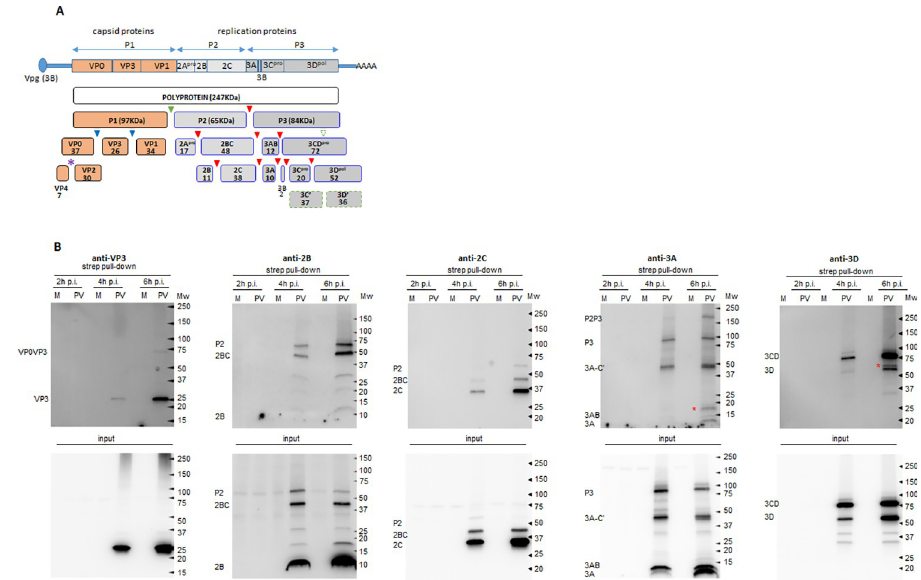
Fig 3. Biotinylation of viral proteins by APEX2-GARG-1060. A. Poliovirus genome and polyprotein processing scheme. The cleavage sites for the viral proteases 2A, 3C, and 3CD are indicated by green, red, and blue-filled triangles, respectively. The dashed empty green triangle indicates a 2A cleavage site in 3D believed to be dispensable for replication. The purple star indicates the autocatalytic cleavage site in VP0. B. HeLa cells stably expressing APEX2-GARG-1060 were infected (PV), or mock-infected (M) with 10 PFU/cell of poliovirus, and biotinylation reactions were performed at the indicated times post-infection. Unfractionated cellular lysates (input) and isolated biotinylated proteins were analyzed in a Western blot with indicated antibodies. The antibodies recognize the final and intermediate polyprotein cleavage products containing the corresponding antigen. Red stars on anti-3A and anti-3D panels indicate polyprotein fragments that do not match the known polyprotein cleavage